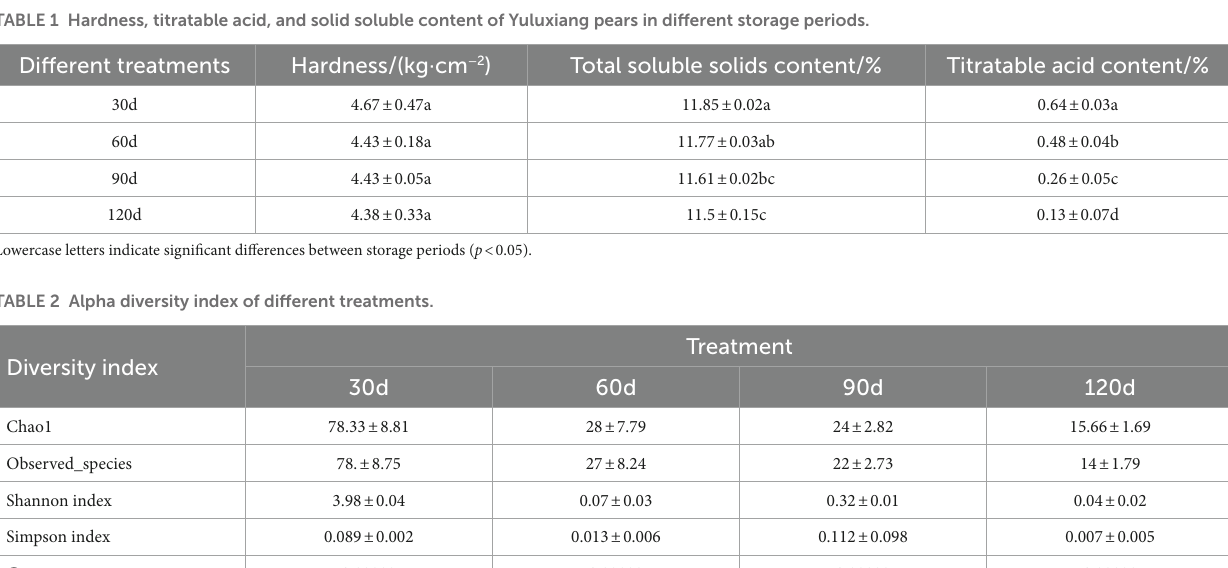
TABLE 1 Hardness, titratable acid, and solid soluble content of Yuluxiang pears in different storage periods. Different treatments